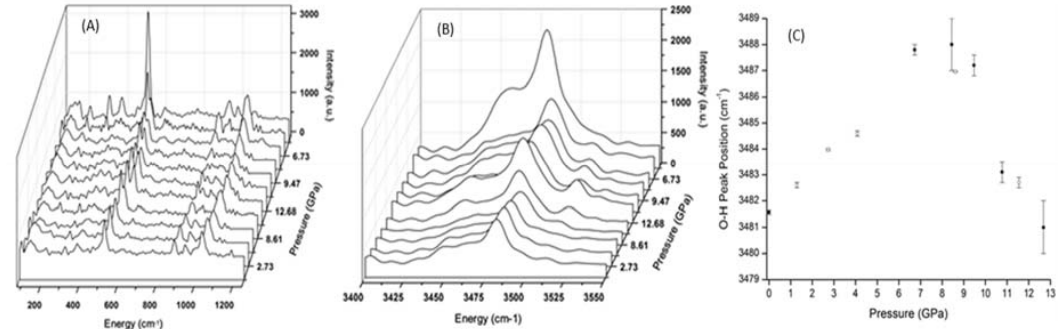
Figure 3. ( A ) Evolution with pressure of the Raman spectra of prehnite between 150–1250 cm − 1 ; ( B ) between 3400–3550 cm − 1 ; ( C ) central position of the primary O–H vibrational peak as a function of pressure. Closed circles: data points measured during pressure increase; open circles: data points recorded during decompression. All spectra have been corrected for background and smoothed by application of the Savitzty–Golay algorithm, to enable the spectral features to be observed.